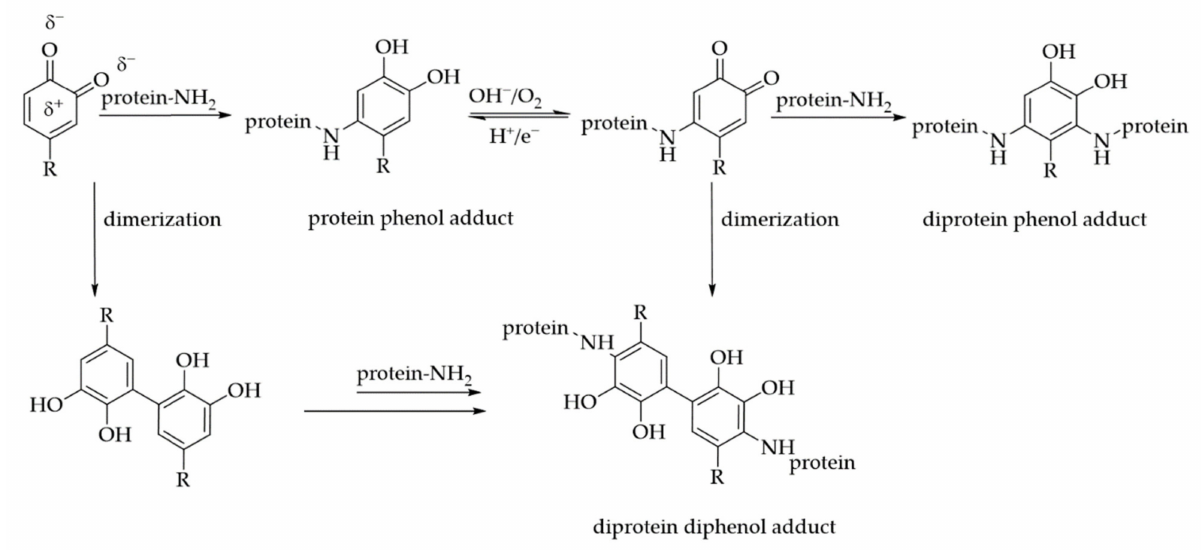
Figure 7. Exemplary crosslinking reaction between PAs (via quinones) and proteins (via lysine